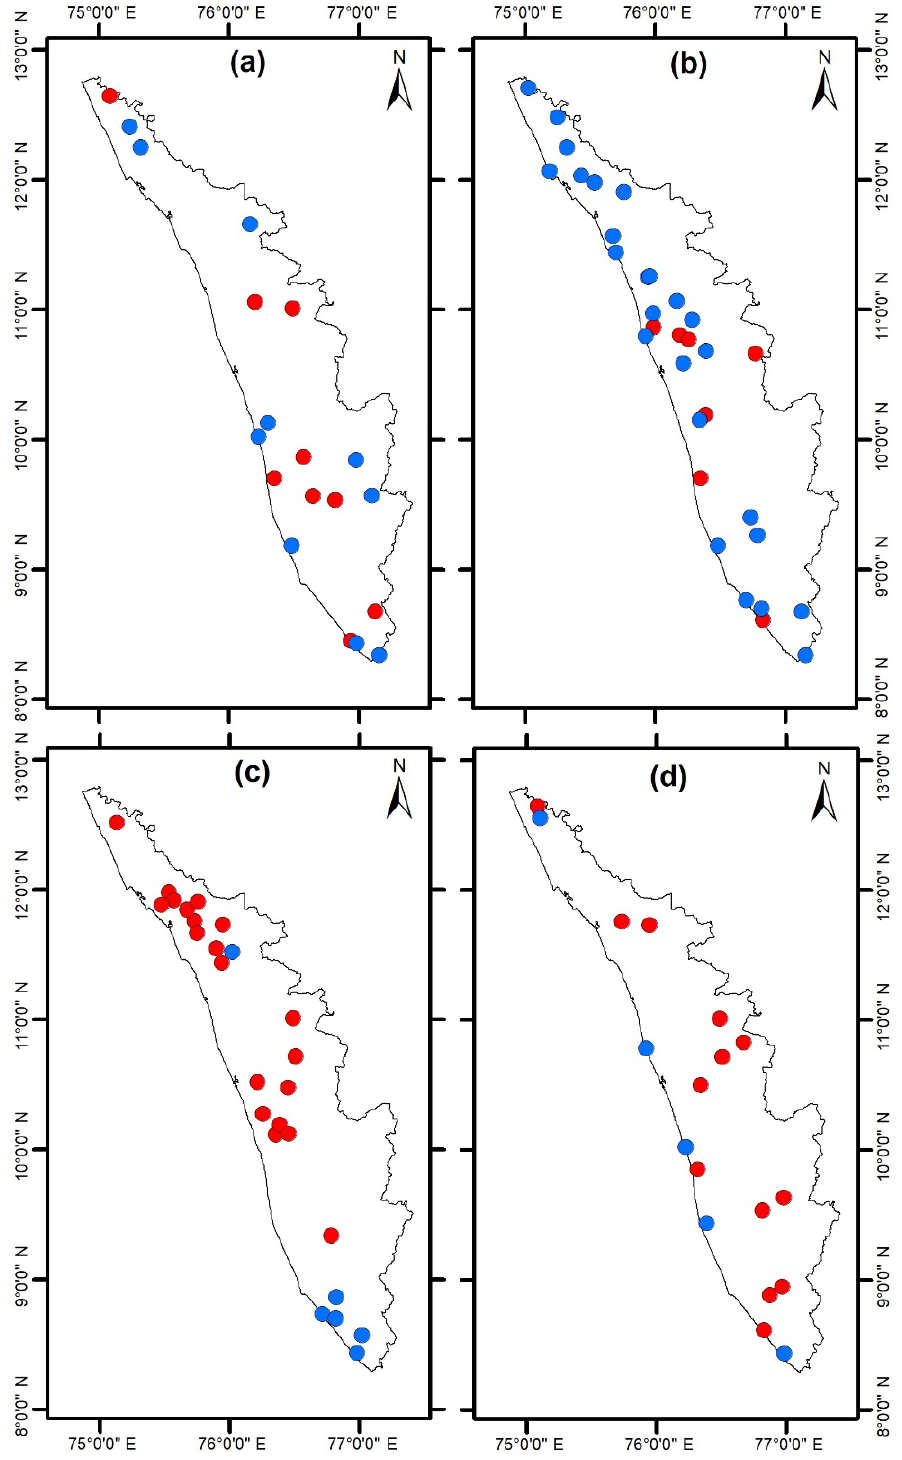
Figure 8. The positive (red) and negative (blue) groundwater level trend locations 19-32-26-18 under focus of study during ( a ) January, ( b ) April, ( c ) August, and ( d ) November.